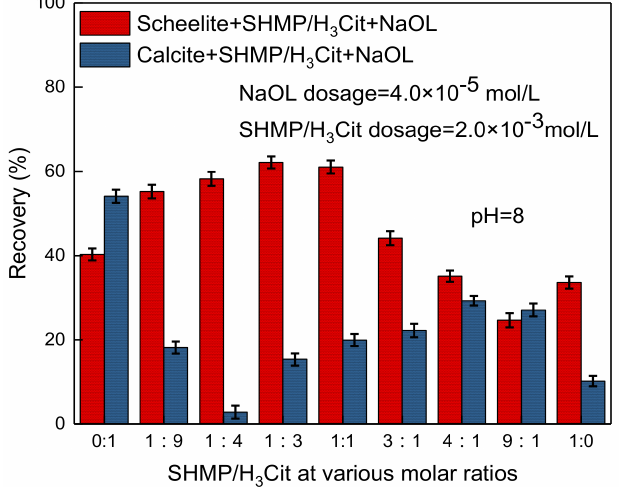
Figure 7. Floatability of minerals with mixed depressants at various molar ratios.